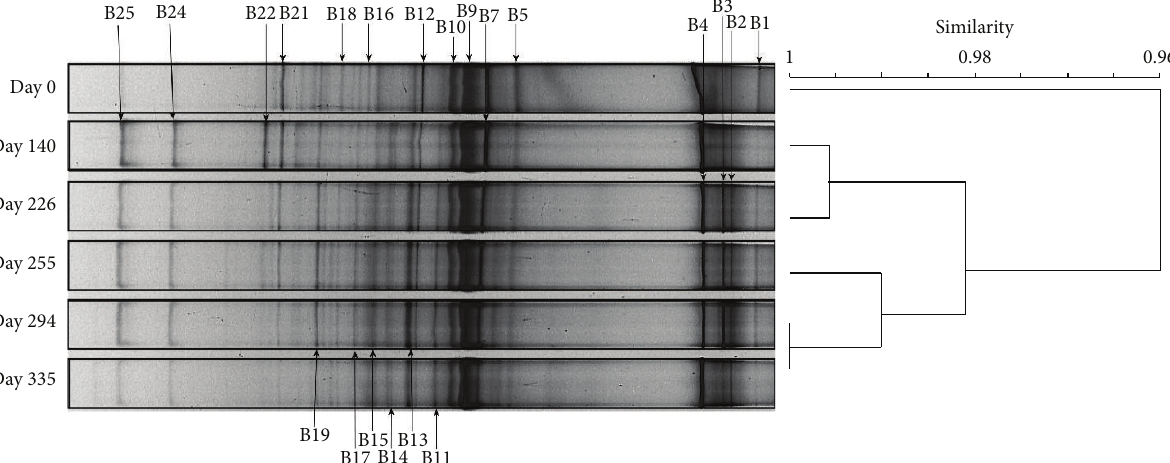
Figure 4: Unweighted Pair Group Method with Arithmetic Mean (UPGMA) cluster analysis of the 16S rRNA gene fragments generated from bacterial denaturing gradient gel electrophoresis (DGGE) profiles of EGSB biomass. Similarity calculated by Sørensons (Bray-Curtis) distance